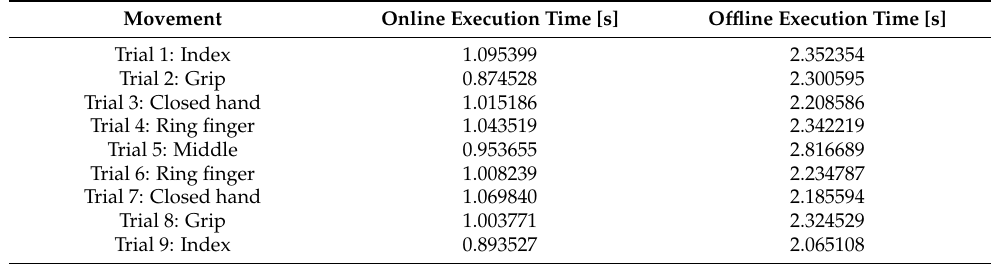
Table 4. Identification of 9 random manual gestures executed online and offline